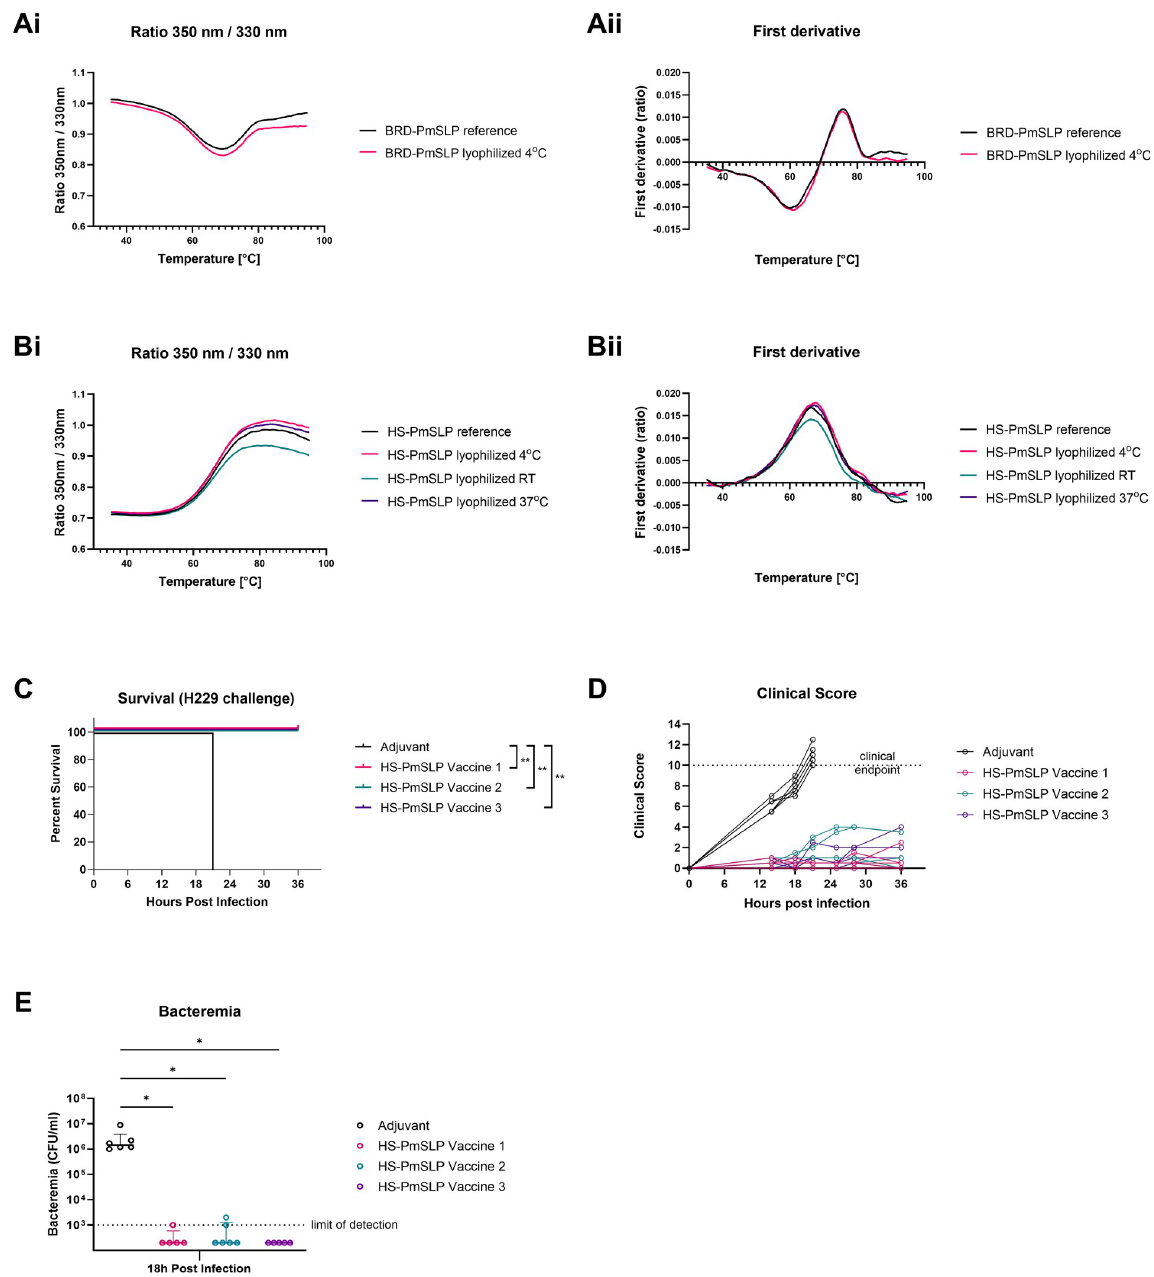
Fig 4. Short term stability of PmSLP antigens. A. Comparison of (i) thermal profile and (ii) first derivative of BRD-PmSLP protein lyophilized and stored at 4˚C for 7 days. B. Comparison of (i) thermal profile and (ii) first derivative of HS-PmSLP protein lyophilized and stored at 4˚C, room temperature (RT), and 37˚C for 14 days. C. Survival of mice that received different HS-PmSLP vaccine preparations after challenge with matched strain H229. Vaccine 1, HS-PmSLP antigen stored at -80˚C after purification and formulated prior to each dose administration; Vaccine 2, HS-PmSLP antigen stored at -80˚C after purification, formulated prior to first dose and stored at 4˚C until the booster; Vaccine 3, lyophilized HS-PmSLP antigen reconstituted and formulated immediately prior to each dose administration. N = 6 mice for adjuvant, N = 5 mice for each vaccinated group. Log-rank (Mantel Cox) tests performed for survival curve comparisons; ** , p < 0.01. D. Clinical scores of individual mice over 36 hours post intraperitoneal challenge. E. Bacteremia in tail vein sample at 18h post infection. Line at median, error bars depict interquartile range. Ordinary 1-way ANOVA with Dunnett’s multiple comparison test performed to compare vaccinated groups to adjuvant control. * , p < 0.05.